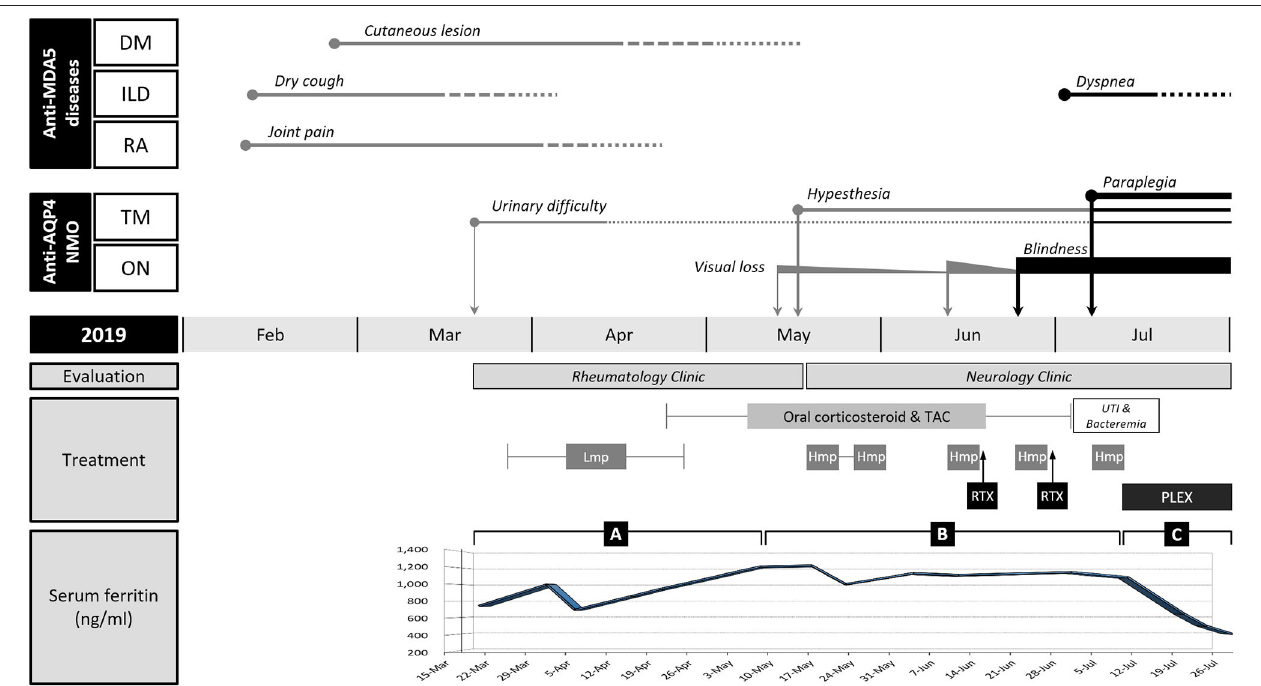
FIGURE 1 | Clinical course and changes in the serum ferritin level of the patient. Anti-MDA5-positive dermatomyositis (DM), interstitial lung disease (ILD), and rheumatoid arthritis (RA) were improved after immunotherapy with corticosteroids and tacrolimus (TAC), but neuromyelitis optica (NMO) frequently relapsed from mid-May (in 2019). NMO and ILD were exacerbated after rituximab (RTX) induction. Hyperferritinemia persisted throughout the course of illness. The change of serum ferritin was divided into three segments based on the inflection points: rising (A) , plateau (B) , and falling (C) phases. (A) Serum ferritin level initially decreased by 30% at the beginning of immunotherapy but kept increasing despite symptomatic improvement of ILD. (B) Serum ferritin level remained high in the period of frequent relapses of NMO. (C) Serum ferritin level drastically dropped after plasma exchange (PLEX). The length of the straight line indicates the duration of symptoms or signs. The thickness of straight lines and the size of circles or rectangles directly indicate clinical severity. The solid line and dotted lines reflect the presence and alleviation of the symptoms, respectively. TM, transverse myelitis; ON, optic neuritis; Lmp, intravenous low-dose methylprednisolone; Hmp, intravenous high-dose methylprednisolone; UTI, urinary tract